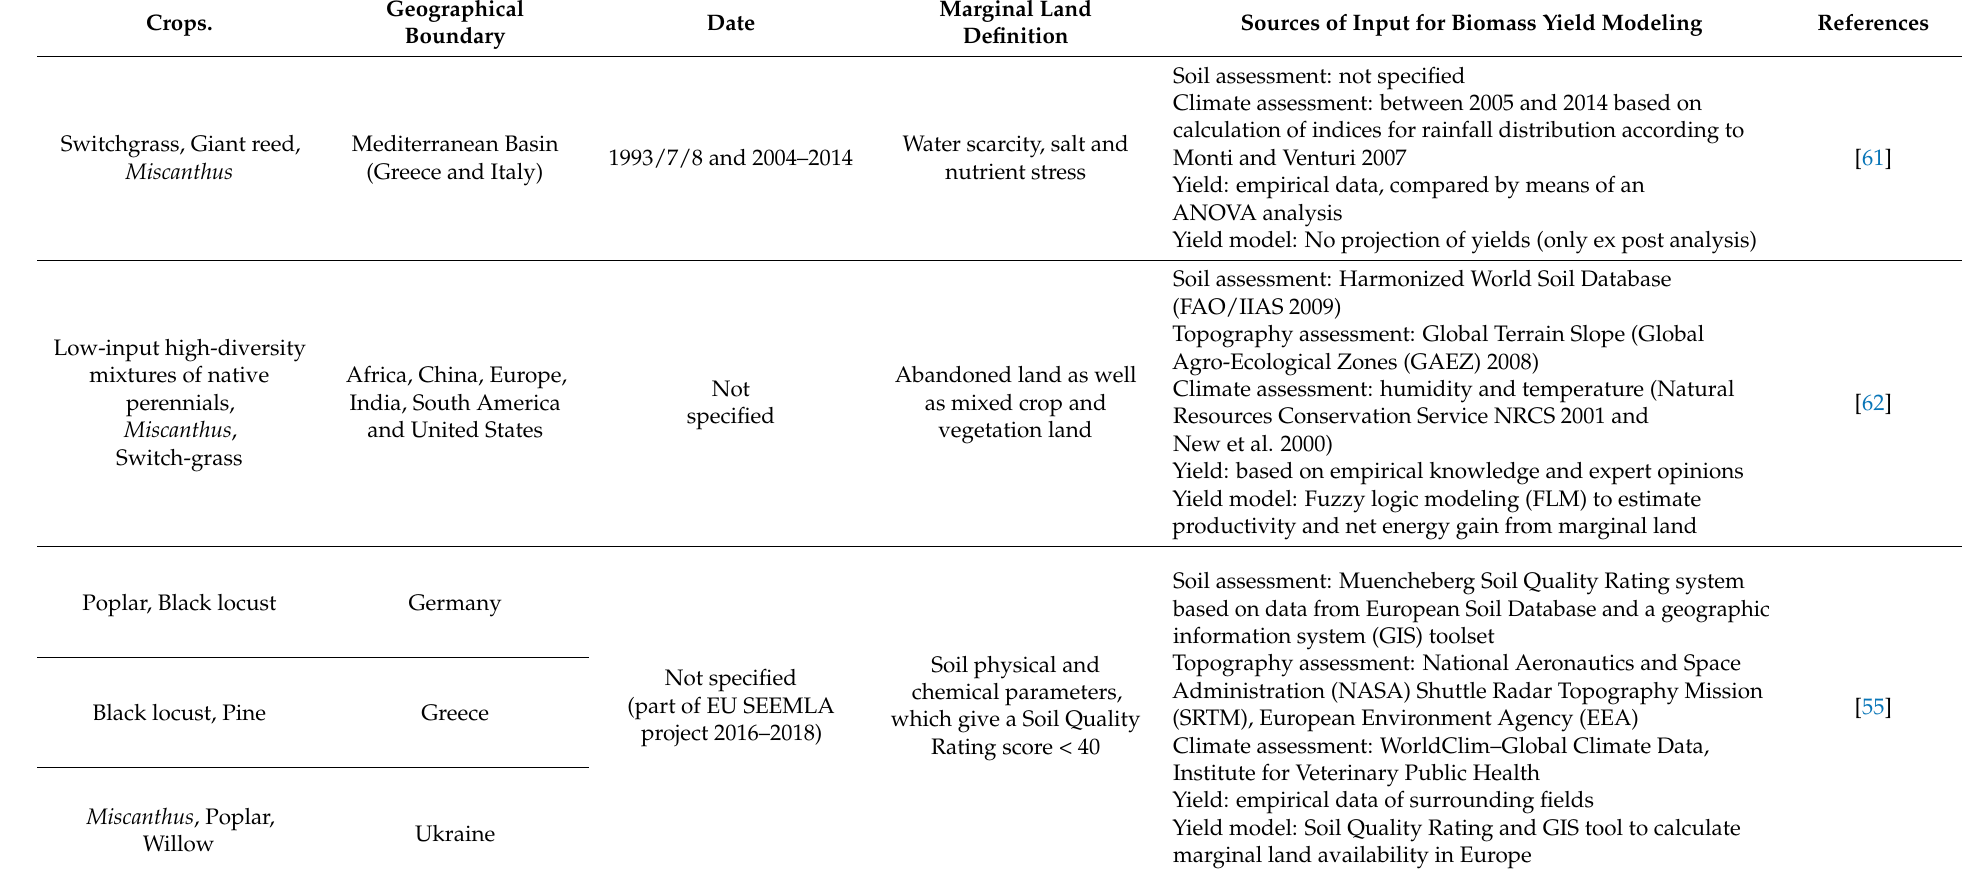
Table 1. Overview of biomass yield modeling studies included in this